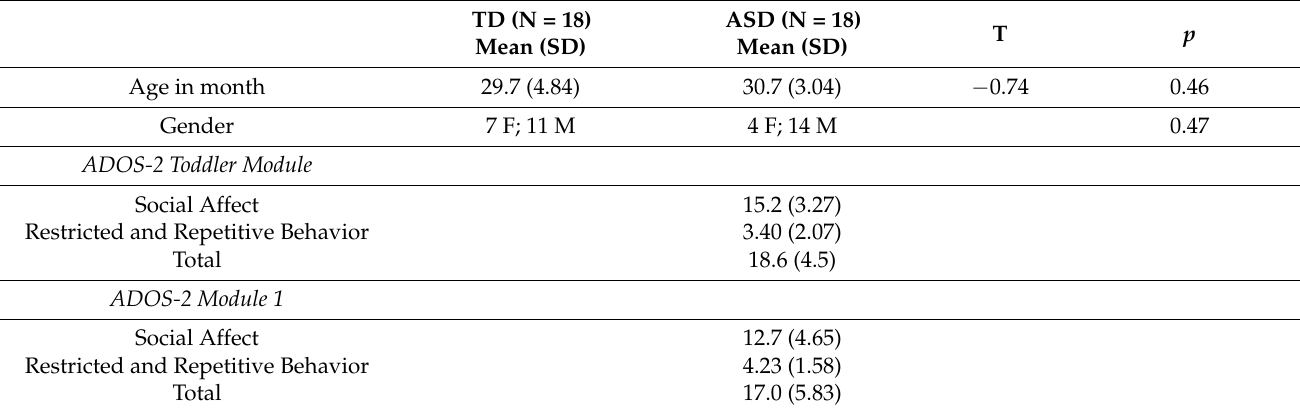
Table 1. Demographic information for both groups and clinical data for the ASD group.